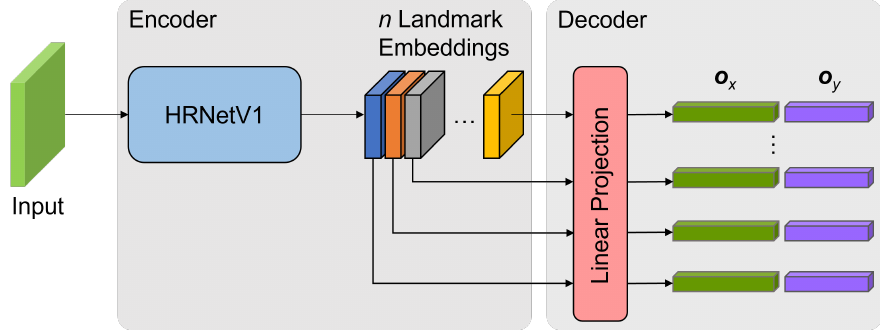
Figure 3. The overall structure of the proposed space target landmark regression